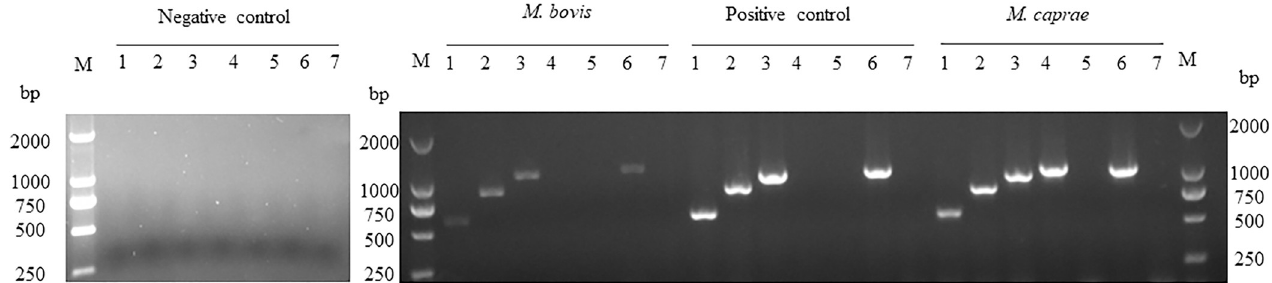
Fig 4. Multiplex PCR typing of the mycobacterium isolates from deer species. Negative control was deionized water; M . bovis was isolated from the tuberculous nodule in the lung of a Pere David’s deer; Positive control was M . bovis ATCC19210; M . caprae was isolated from the abscesses in the right submaxillary face of a roe deer. Lanes: 1, 16S Rrna (543 bp); 2, Rv0577 (786 bp); 3, IS 1561’ (943 bp); 4, Rv1510 (1033 bp); 5, Rv1970 (1116 bp); 6, Rv3877/8 (999 bp); 7, Rv3120 (404 bp); M, 2000 bp DNA ladders.